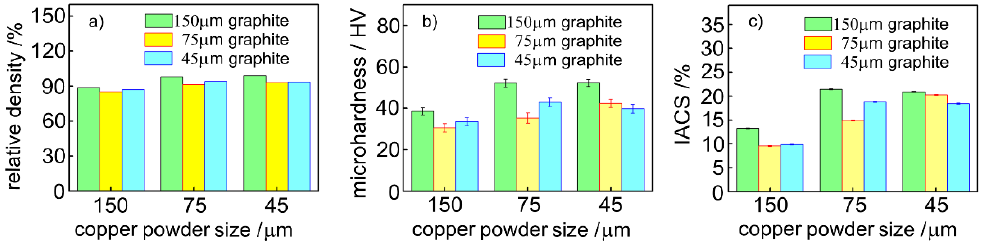
Figure 3. Obtained copper-graphite composite materials relative to the density ( a ), hardness ( b ), and electrical conductivity ( c ).